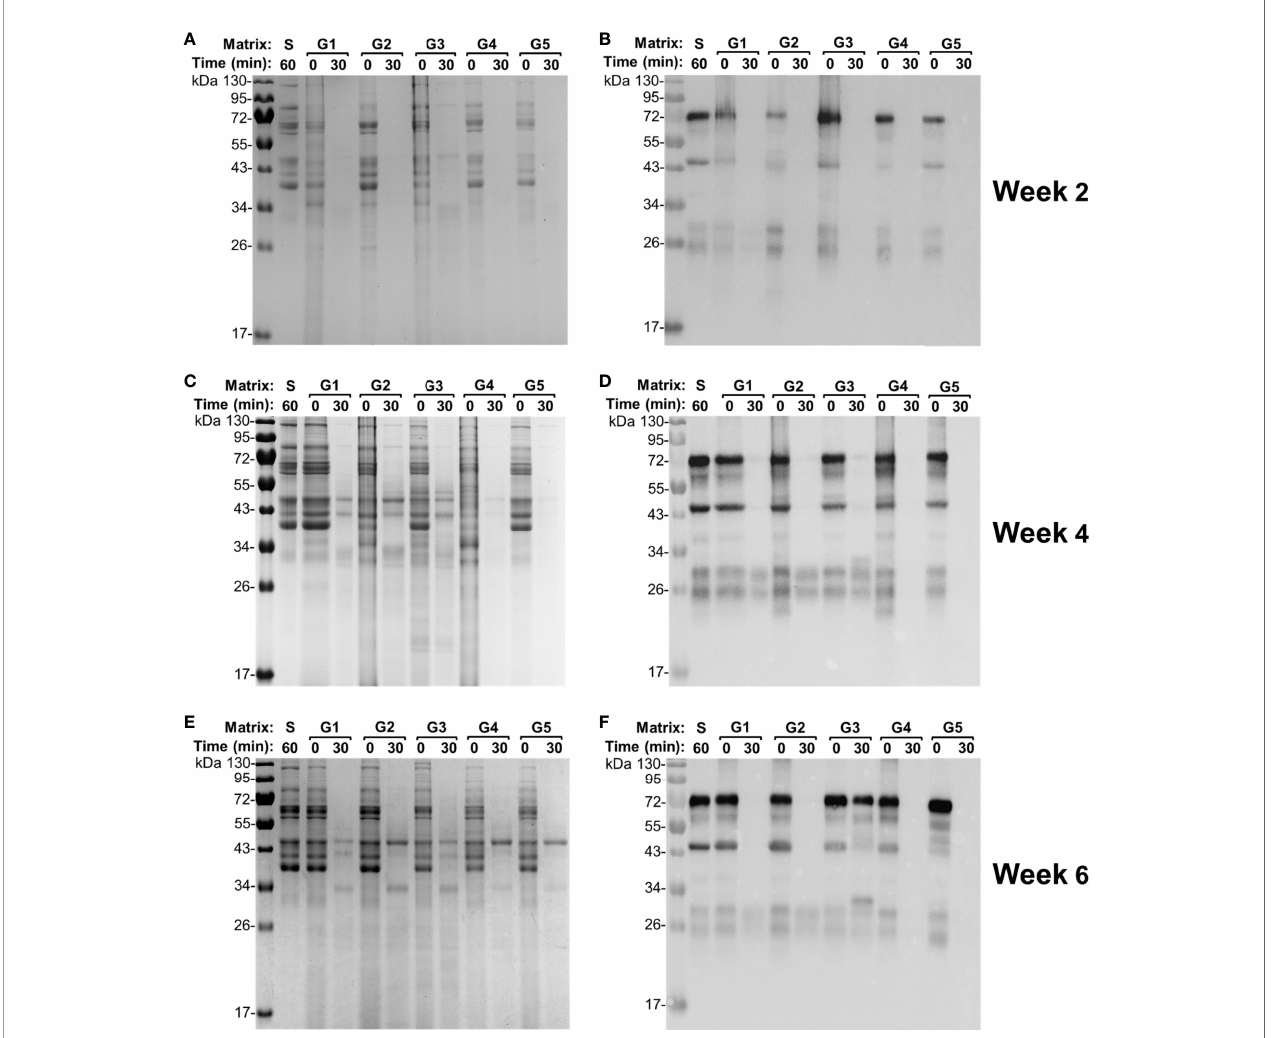
FIGURE 3 | Integrity of egg yolk IgY in response to the treatment with the gizzard content collected from each individual chicken. (A) SDS-PAGE and (B) immunoblotting analyses of the integrity of egg yolk IgY in response to the treatment with each individual gizzard content collected at 2 weeks of age at 42°C for 0 or 30 min. The reconstituted hyperimmune egg yolk powder was used as stock to spike the gizzard content matrixes as described in the Materials and Methods . The far left lane is a protein marker. Abbreviation of the matrix system for treating egg yolk IgY: S, saline; G1 – G5, gizzard contents of fi ve individual chickens at 2 weeks of age (indicated on the right). Likewise, (C) SDS-PAGE and (D) immunoblotting analyses of the integrity of egg yolk IgY upon treatment in each individual gizzard content collected at 4 weeks of age; (E) SDS-PAGE and (F) immunoblotting analyses of the integrity of egg yolk IgY upon treatment in each individual gizzard content collected at 6 weeks of